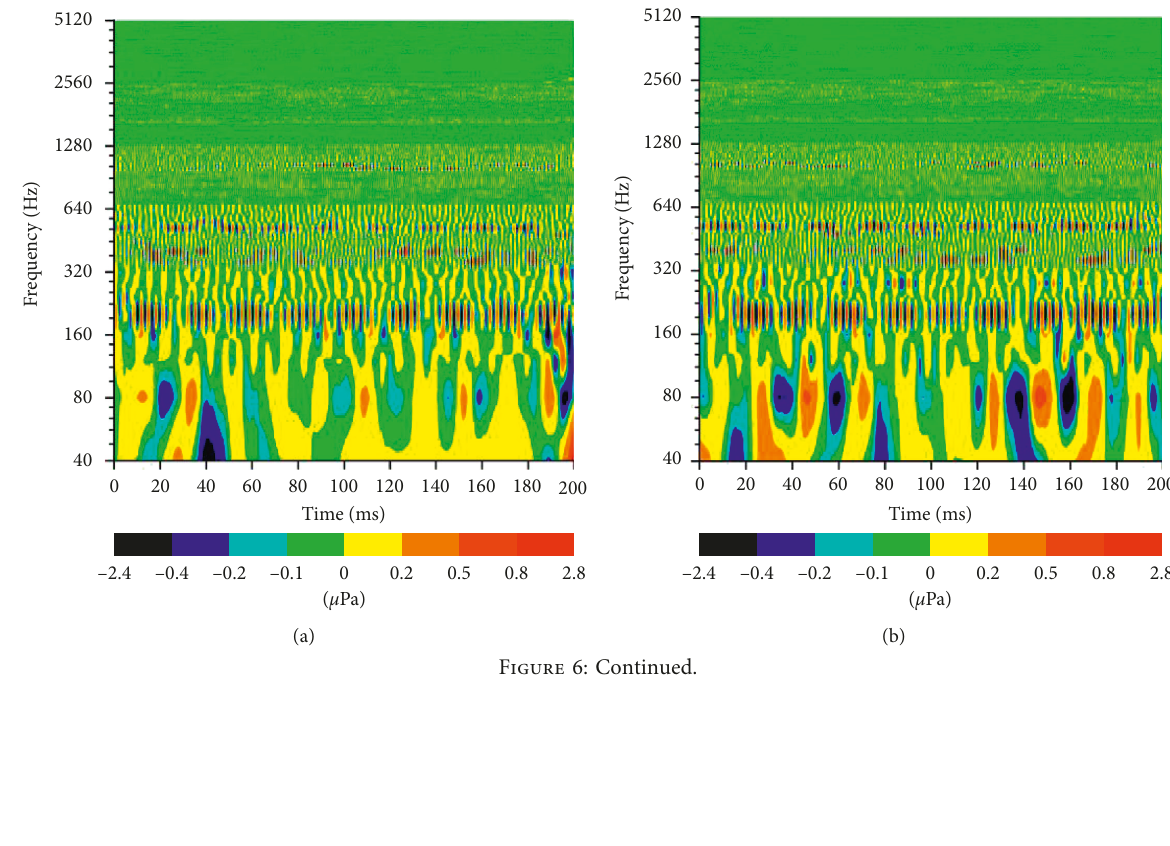
Figure 5: Frequency spectrum of cavitation noise at rated flow rate: (a) noncavitation stage σ σ 0.021; (c) severe cavitation stage σ (cid:28)